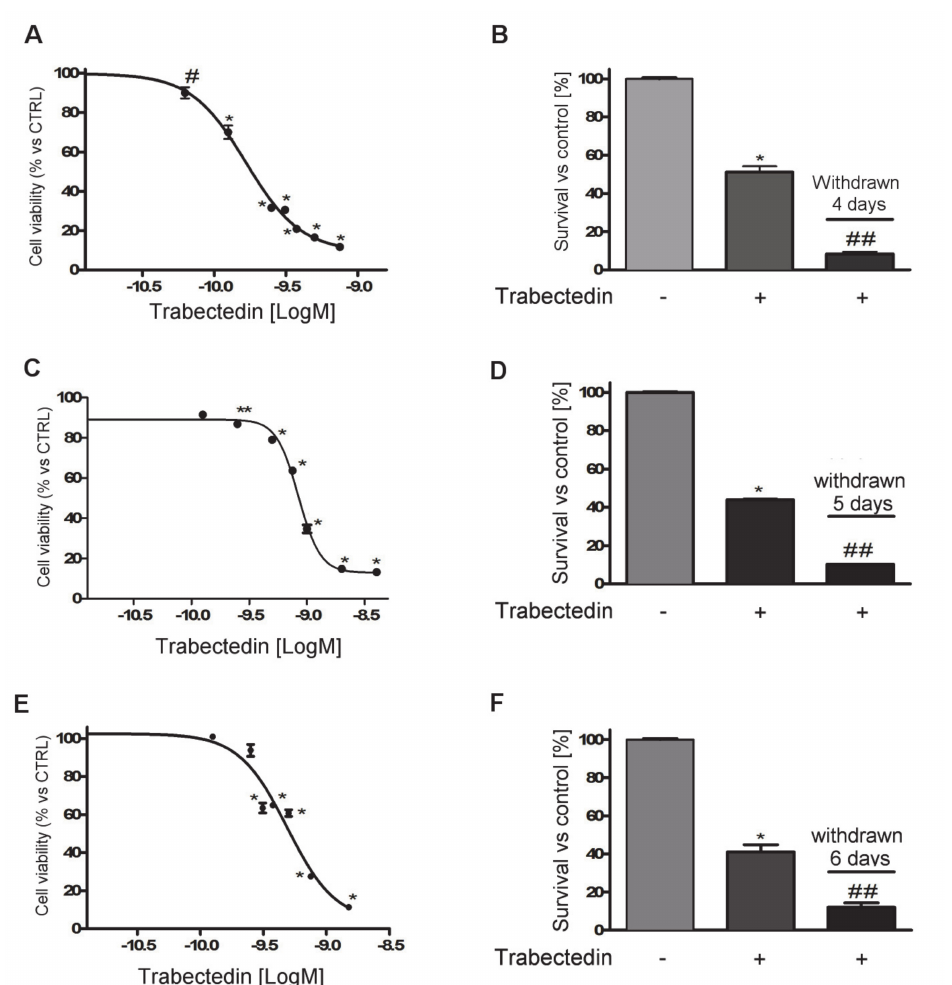
Figure 1. Cytotoxic e ff ect of trabectedin in adrenocortical carcinoma (ACC) cell models. ( A ) Concentration–response curve of trabectedin-induced inhibition of cell viability of in NCI-H295R cells. Cells were treated with increasing concentrations of trabectedin (0.0625–0.75 nM) for 4 days. ( B ) Cytotoxic e ff ect lasted after trabectedin withdrawn. Cells were treated with the trabectedin IC50 (0.15 nM) for 4 days, then trabectedin was withdrawn from medium, and cells were kept in culture for a further 4 days. ( C ) MUC-1 cells were treated for 5 days with increasing concentrations (0.125–2.0 nM) of trabectedin. ( D ) MUC-1 cells were treated with 0.80 nM trabectedin for 5 days, then trabectedin was withdrawn from medium, and cells were kept in culture for a further 5 days. ( E ) The sub-clone HAC-15 cells were treated for 6 days with increasing concentrations (0.125–1.5 nM) of trabectedin. ( F ) HAC-15 cells were treated with 0.50 nM trabectedin for 6 days, then trabectedin was withdrawn from medium, and cells were kept in culture for a further 6 days. Cell viability was analyzed by MTT assay. Results are expressed as percent of viable cells vs. untreated cell ± SD; * p < 0.0001 vs. control; # p < 0.001